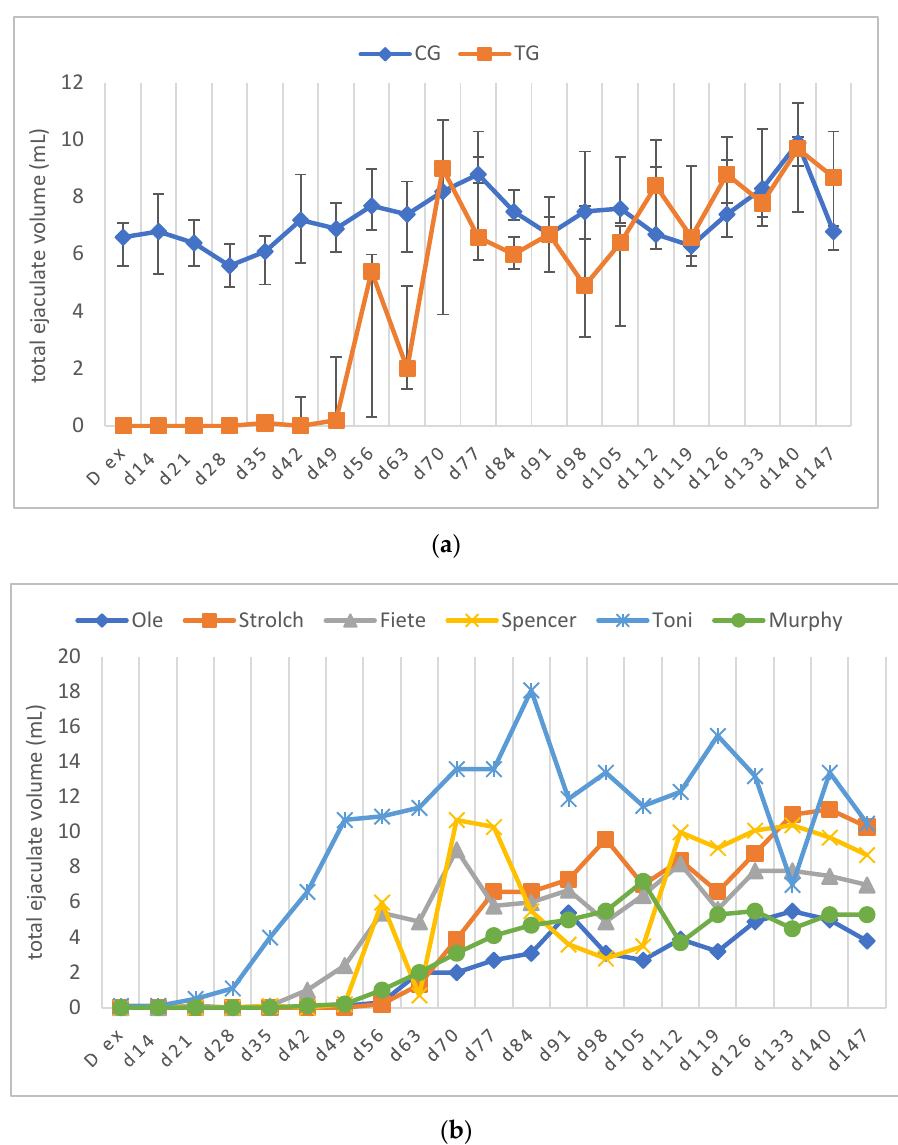
Figure 4. ( a ) Total ejaculate volume (mL) given over time as median (Q1, Q3) of animals treated with a 4.7 mg deslorelin implant (TG, n = 5, excluding Murphy) and saline- treated control animals (CG, n = 3). ( b ) Total ejaculate volume (mL) given as individual courses of animals treated with a 4.7 mg deslorelin implant (TG, n = 6) over time.